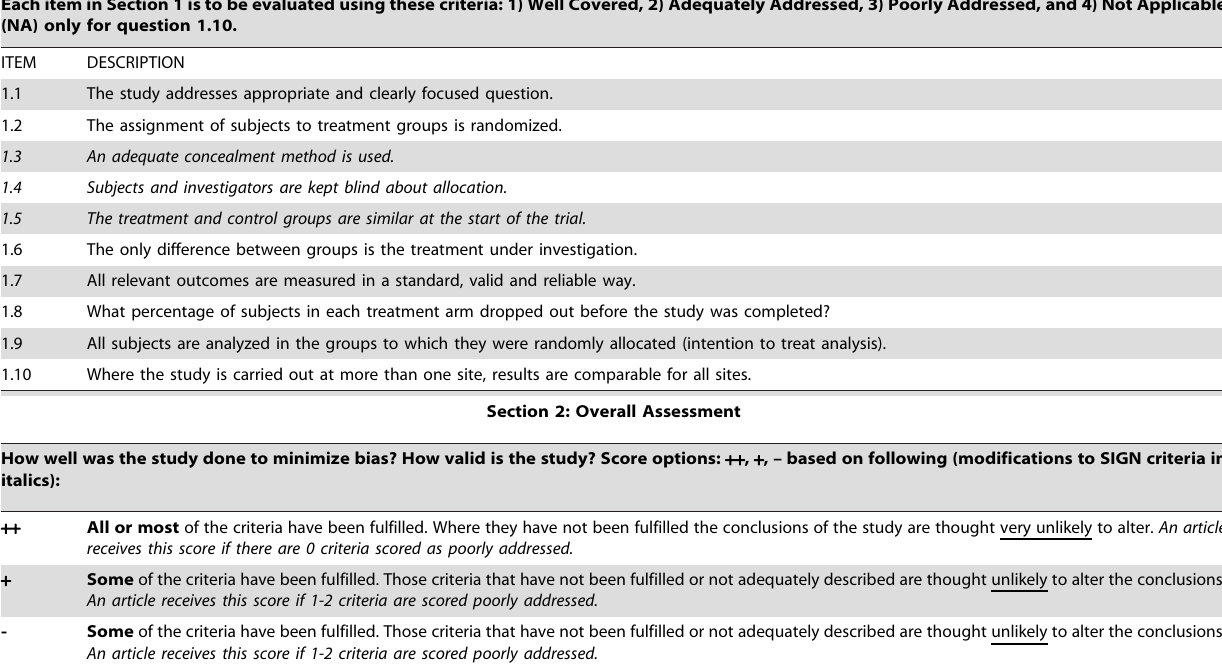
Table 1. SIGN 50 Checklist for RCT Study Design.